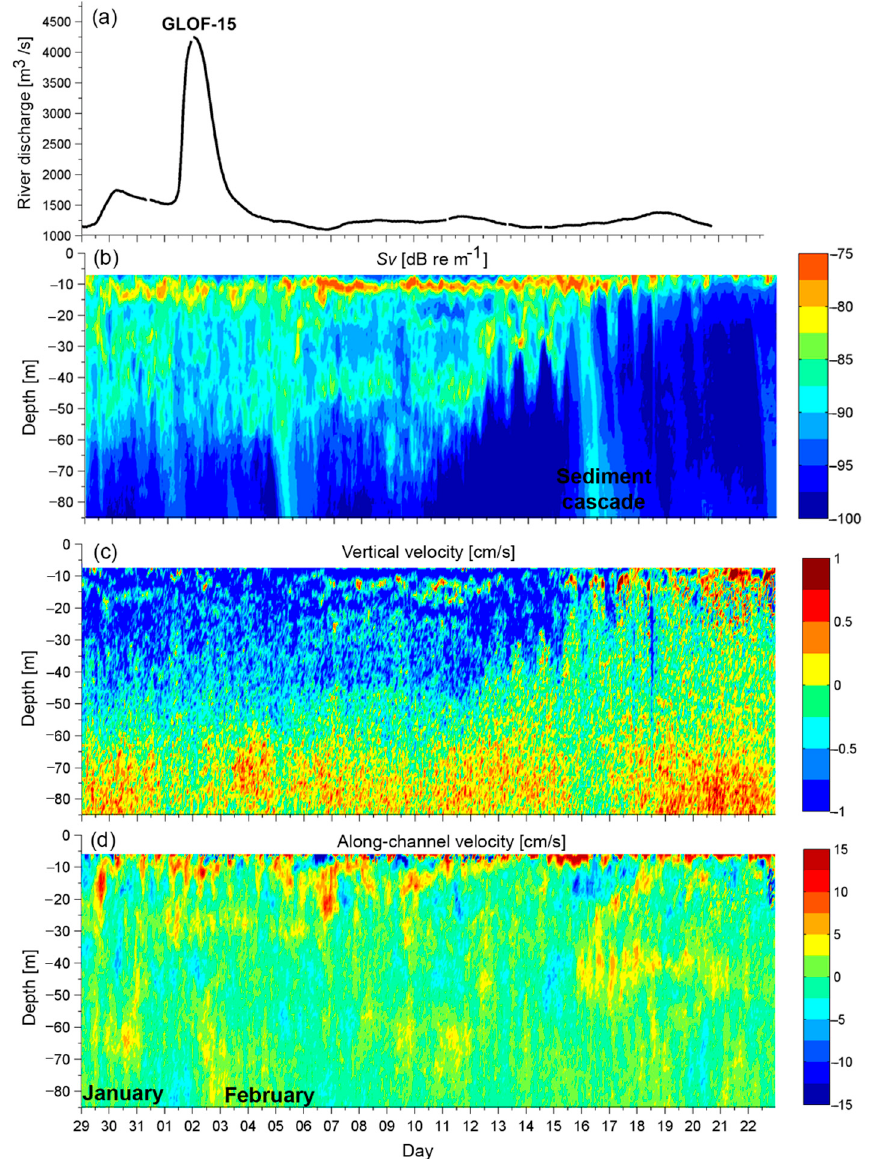
Figure 10. ( a ) Hourly measurements of river discharge at Ñadis station showing the GLOF-15 event occurrence on 1 February 2014, ( b ) volume backscatter, S v indicating the occurrence of the sediment cascade (16 February) ( c ) vertical velocity, w and ( d ) along-channel velocity, u where positive values denote in-fjord flow and negative values denote out-fjord flow.